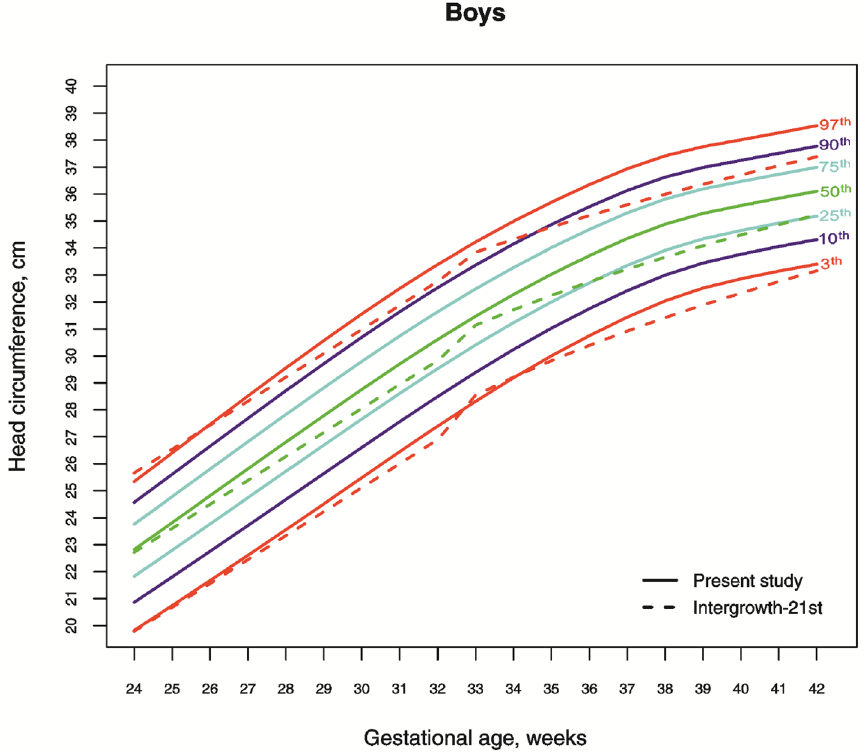
Figure 1. The 3rd, 10th, 25th, 50th, 75th, 90th and 97th smoothed percentile curves for head circumference (cm) in Lithuanian neonate boys and the 3rd, 50th and 97th percentiles for INTERGROWTH-21st 20,25